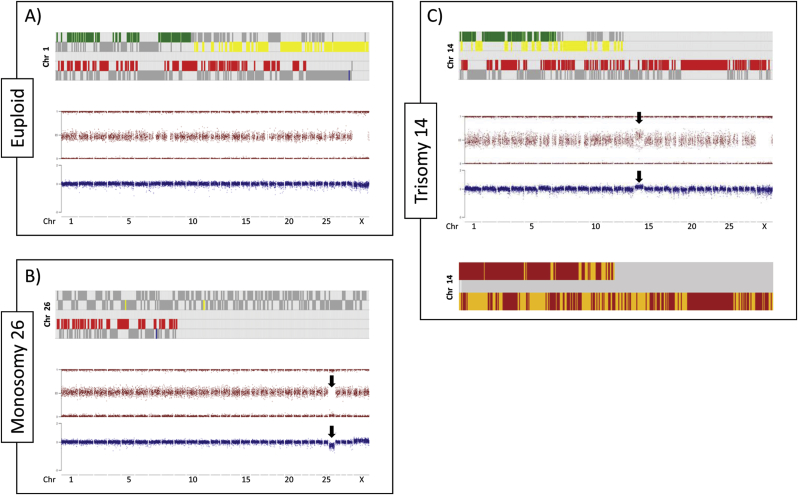
Chromosome analysis outputs of bovine blastocysts. Each aneuploidy was analysed by multiple algorithms: Karyomapping, Signal strength intensity metrics (BAF and LRR) and, in the case of trisomies, Gabriel-Griffin plots. With Karyomapping, a diagram for each chromosome illustrates which haploblocks the embryo inherited from its dam (yellow/green) and sire (blue/red). Euploid chromosomes are identified by few, continuous blocks of yellow/green or blue/red bands, a pattern that becomes altered in aneuploidy resulting in excessive banding in trisomies and absent haploblock inheritance in monosomies. Signal strength intensity graphs plot the signal strength intensity of SNP alleles A and B relative to each other (for BAF plots) or combined (in LRR plots). Euploid chromosomes display 3 signal clusters in a BAF plot according to each genotype (BB = 1, AB = 0.5, AA = 0) and a single consistent cluster of data close to the average expected signal intensity in LRR the plots. Monosomies appear as a loss of the AB cluster in the BAF graph and a decrease in signal intensity in the LRR graph for a specific chromosome; conversely, trisomies result in the gain of an additional signal cluster in a BAF graph (for the possible allele combinations BBB, ABB, AAB, AAA) and an increased signal intensity on the LRR graph for the specific chromosome. In Gabriel-Griffin Plots, for each trisomy, parental haploblocks are defined and a diagram is drawn highlighting heterozygous genotype calls in red and homozygous calls in yellow. Trisomies originating in Meiosis I show an uninterrupted heterozygous pattern around the centromere, Meiosis II error are identified by yellow blocks around the centromere, and mitotic errors are characterized by a variegated yellow and red pattern across the chromosome. (A) Top = Euploid Karyomapped chromosome 1; Middle (in red) and Bottom (in blue) = BAF and LRR graphs (respectively) also demonstrating an euploid karyotype. (B) Top = Monosomy 26 of maternal origin, note the absence of any yellow/green (maternally inherited) haploblocks; Middle (in red) and Bottom (in blue), BAF and LRR graphs (respectively) demonstrating the same monosomy (arrows). (C) Top = Trisomy 14 of maternal origin, note the excess yellow/green banding; Middle (in red) and Bottom (in blue) graphs = BAF and LRR graphs (respectively) demonstrating the same trisomy (arrows); Bottom most = Gabriel-Griffin plot suggesting this trisomy originated in the maternal germline during Meiosis I (due to the prominent red pattern encompassing the top two thirds of chromosome 14 and, therefore, its centromere).